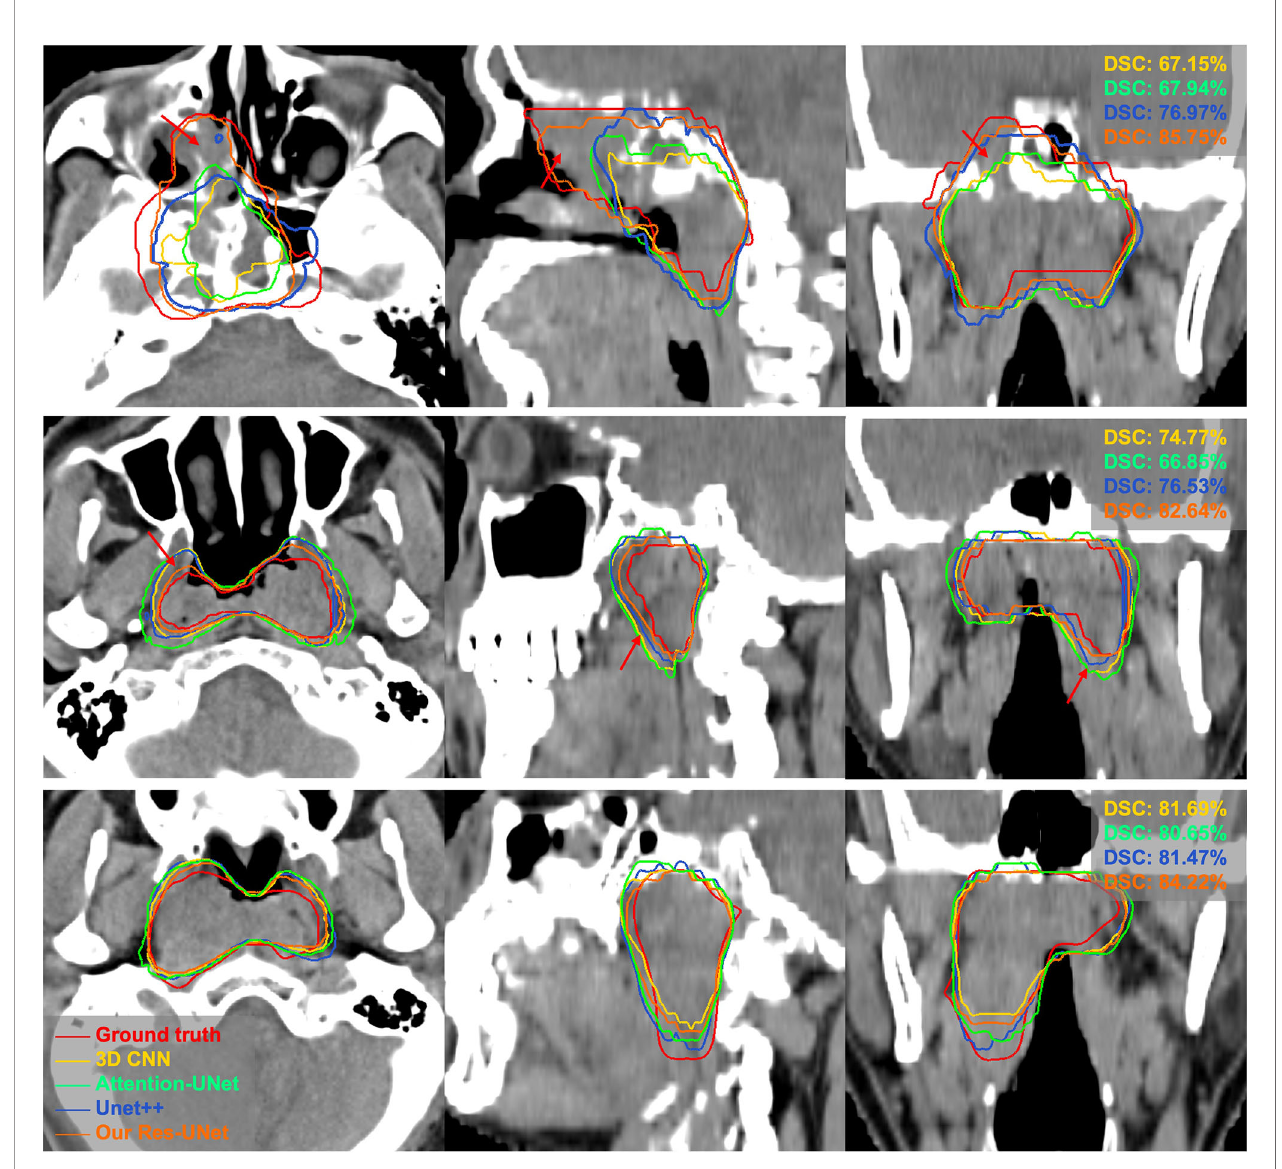
FIGURE 3 | Visual comparison of different networks for GTV segmentation. The red arrows denote false positives and poorly segmented areas. Note that these results derived from the models trained on pCT and CE-CT data are shown in